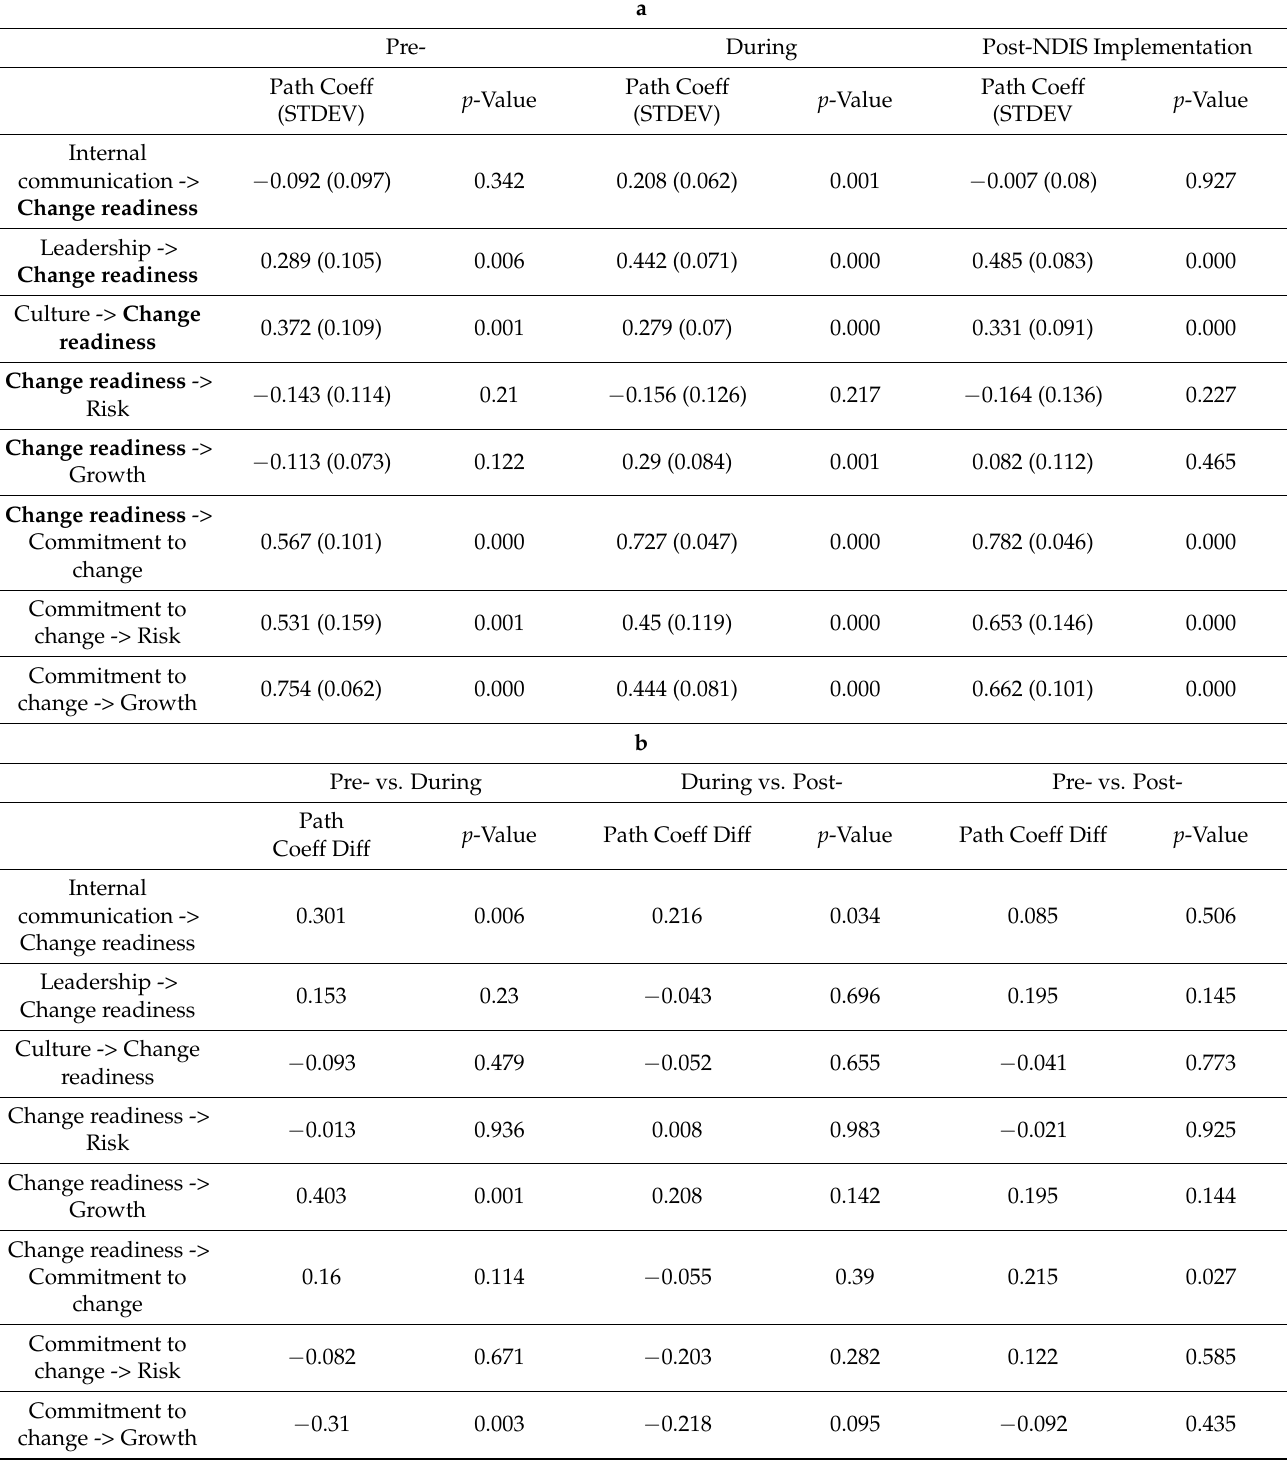
Table 6. a. Three-stage model comparisons. b. Regression coefficient